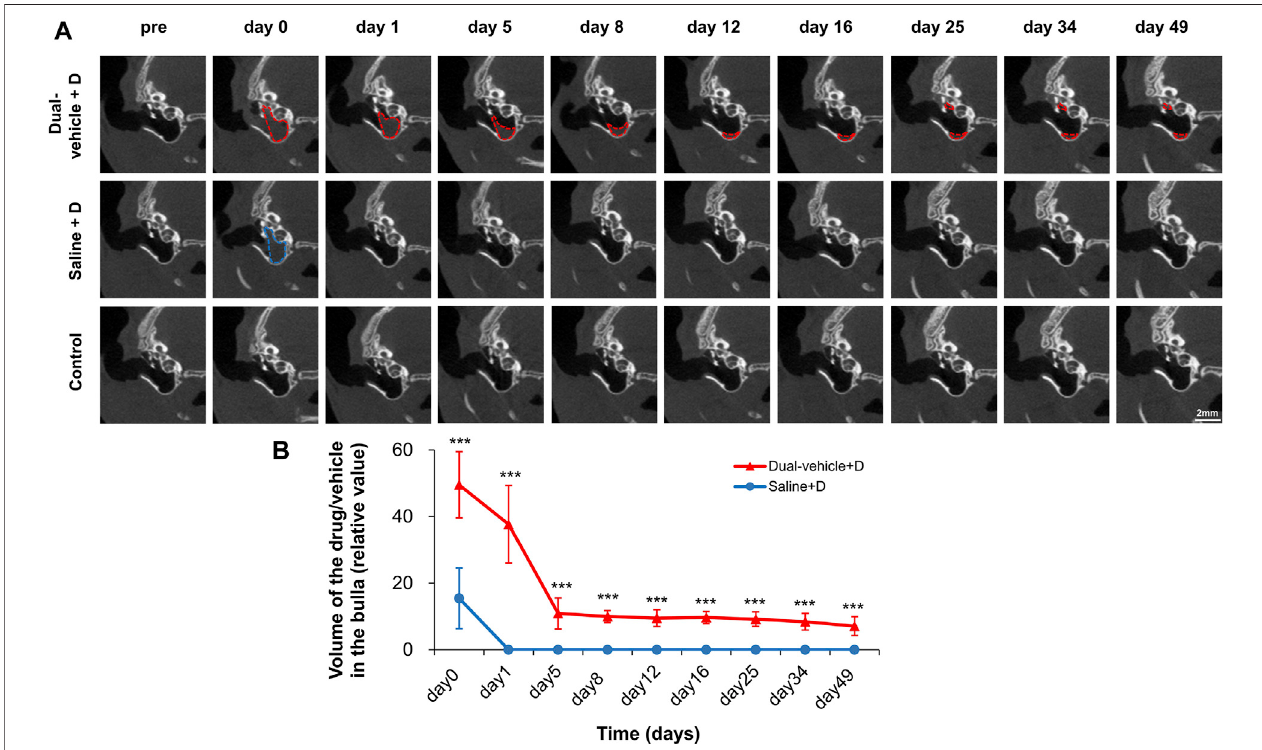
FIGURE 3 | Amount of drug/vehicle remaining in the middle ear after IT drug delivery. The duration of drug/vehicle residence in the middle ear was evaluated using micro-computed tomography (CT). In the dual-vehicle + D group, the middle ear was fi lled with drug/vehicle on day 0. The volume rapidly decreased within 5 days, but there was still a visible amount of drug/vehicle (indicated by red and blue dotted lines) at up to 49 days (A) . In the saline + D group, the amount of drug/vehicle visible decreased much faster from the time of the fi rst micro-CT; after 24 h, there was littleevidence ofany remaining drug/vehicle (B) . * p < 0.05, ** p < 0.01, *** p < 0.001 compared to the saline + D